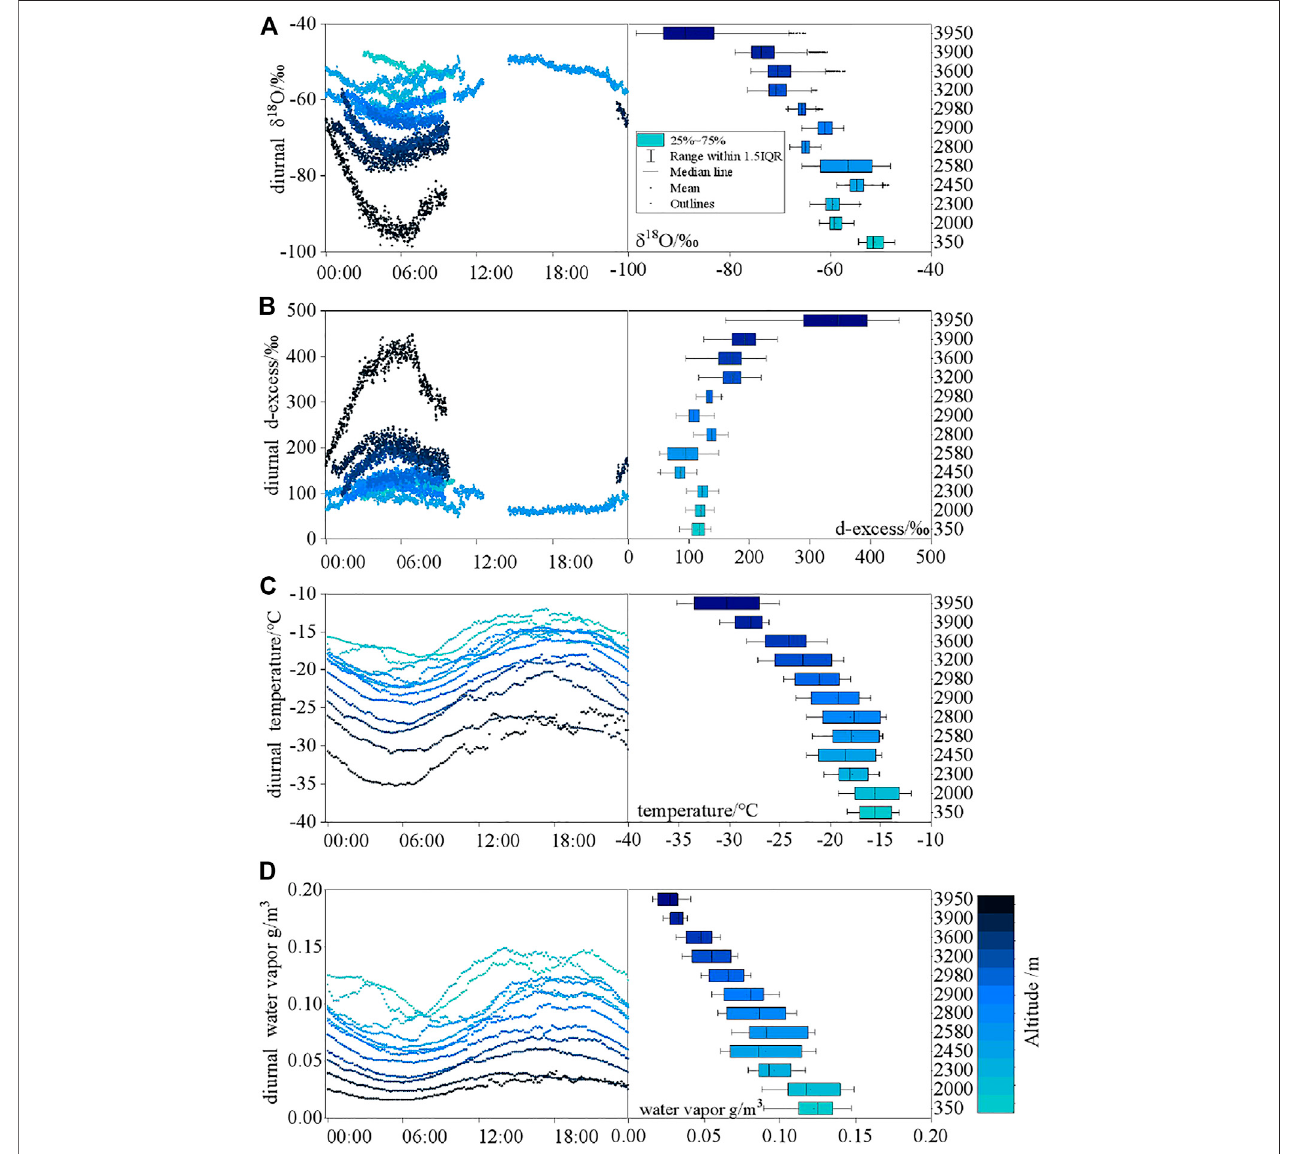
FIGURE5| Diurnalcyclesduringthemonitoringperiod. (A) δ 18 O, (B) d-excess, (C) 2 mairtemperature,and (D) watervaporcontent.Thecolorsuccessivechange represents gradual distance variation from near coastal to interior inland Antarctica. All the signals are dominated by the presence of diurnal cycles with the isotope variation amplitude increased to